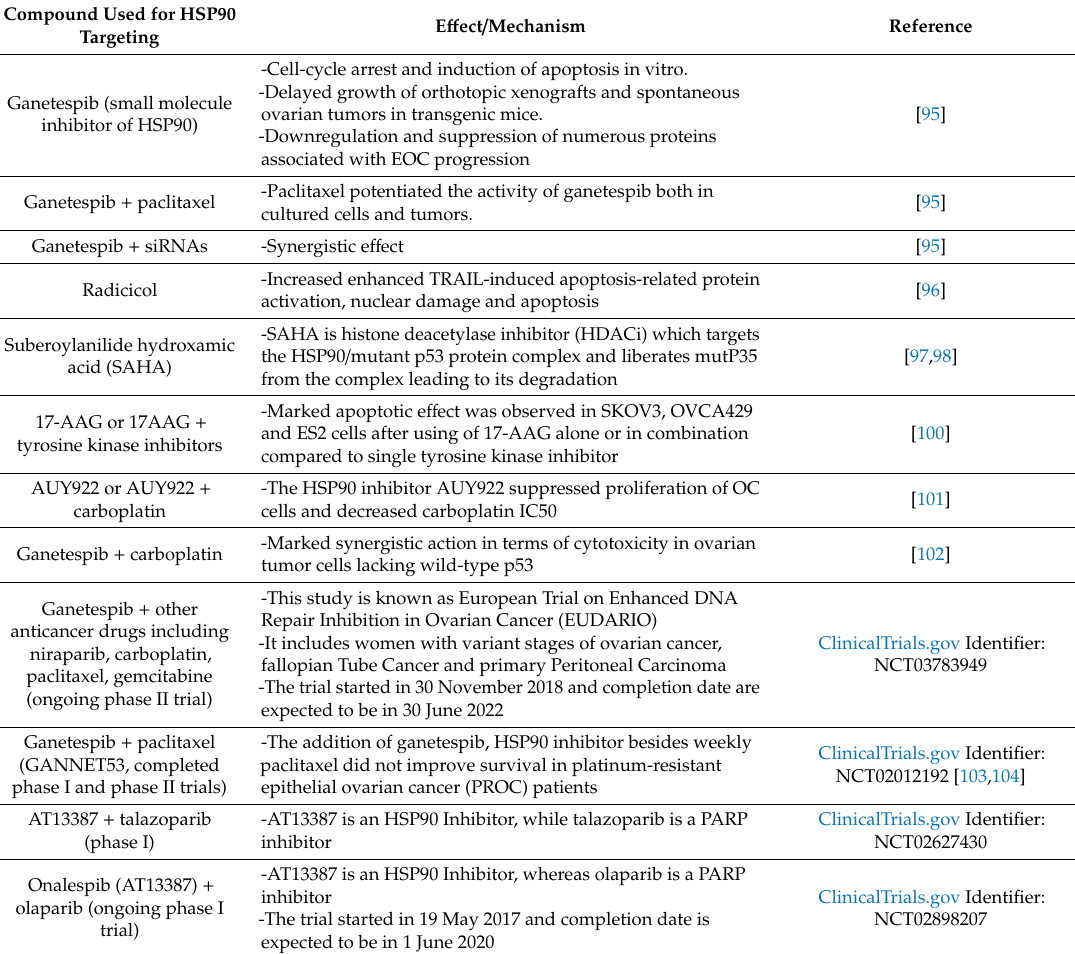
Table 2. Summary of studies and clinical trials related to HSP90 targeting in ovarian cancer (OC). Compound Used for HSP90